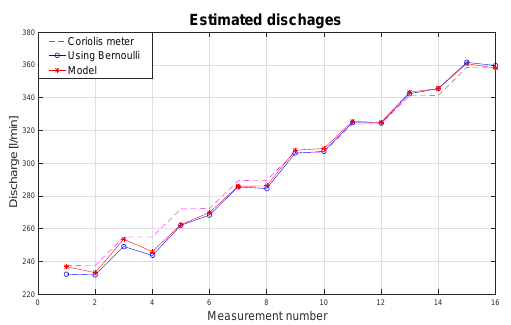
Figure 8: Moving average filter with a size of 60 samples